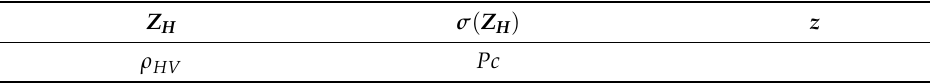
Table A1. Input measurements of clutter classification.